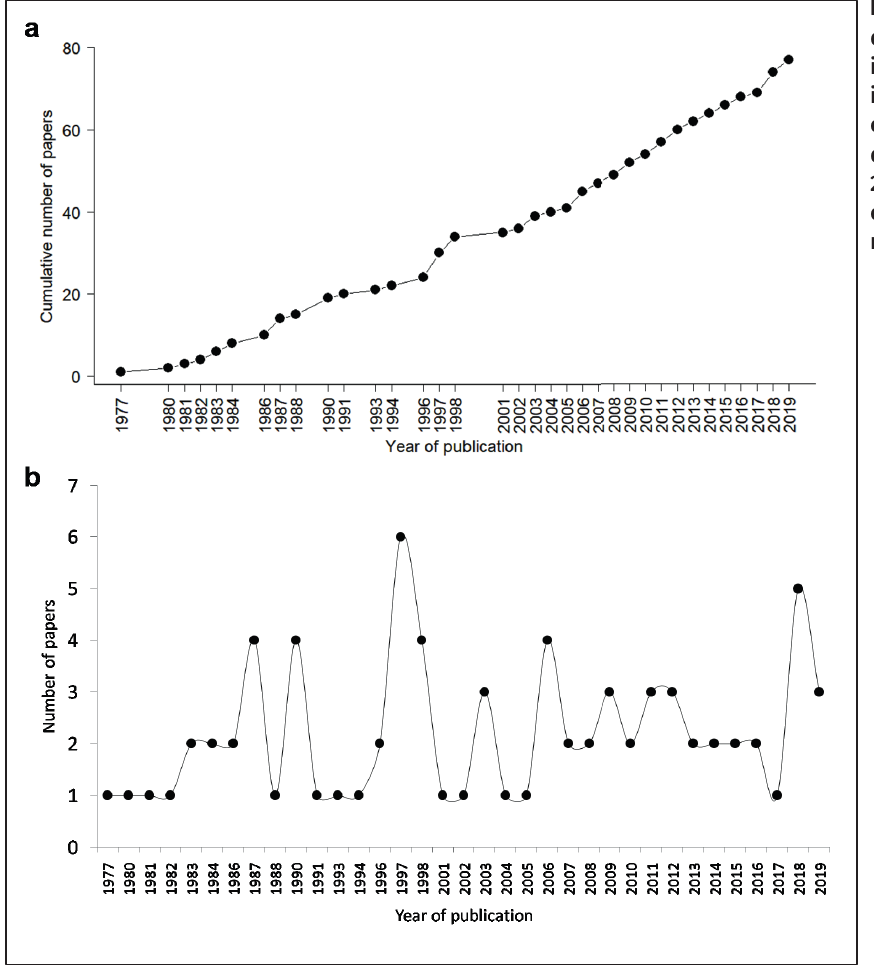
Figure 2. Temporal distribution of studies involving microcrustaceans in rice fi elds in the Web of Science and Scopus databases between 1977